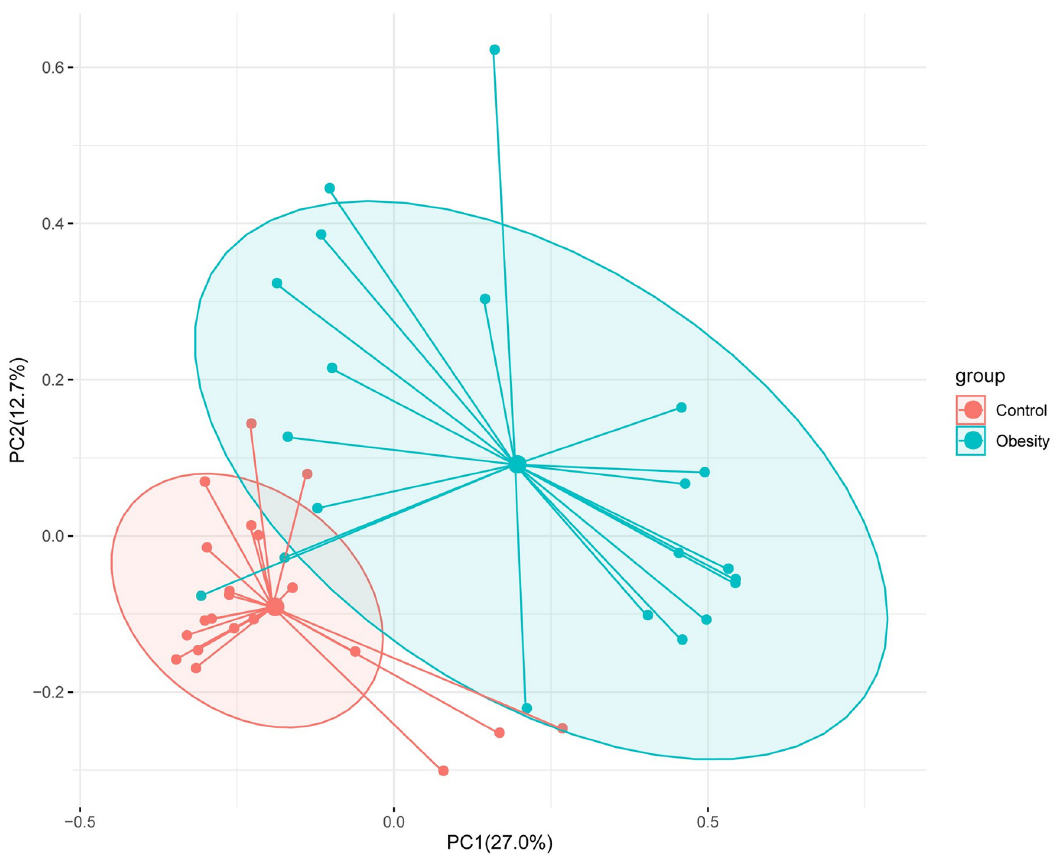
Fig 5. Principal co-ordinates analysis (PCoA) with Bray-Curtis dissimilarity based on genera.